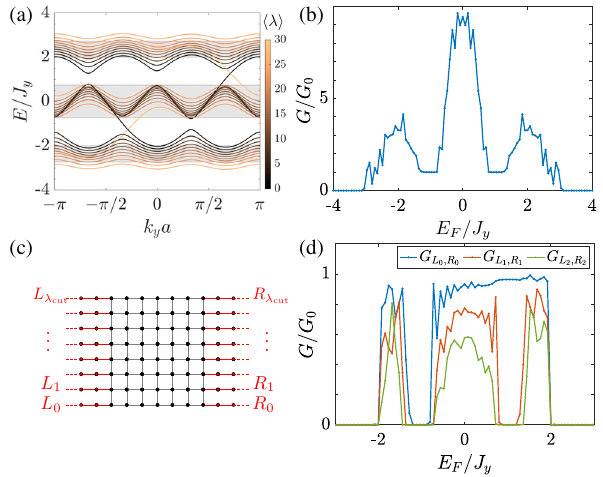
FIG. 7. (a) Energy dispersion of the complete effective model with λ -dependent hopping [Eq. (6)] for periodic boundary 30 . The color scale indicating conditions along y and λ cut ¼ the mean position h λ i of the eigenstates along the synthetic dimension is chosen so as to highlight low- λ states (darker colors). The shaded regions correspond to the bulk bands of the homogeneous and isotropic model of Sec. III B. (b) Two-terminal conductance of the complete effective model in Eq. (6). (c) Sketch of the effective multiterminal geometry with N ¼ 0 ; … ; λ , and cut (d) the resulting conductances G L for λ ¼ 0 , 1, 2. λ ;R λ